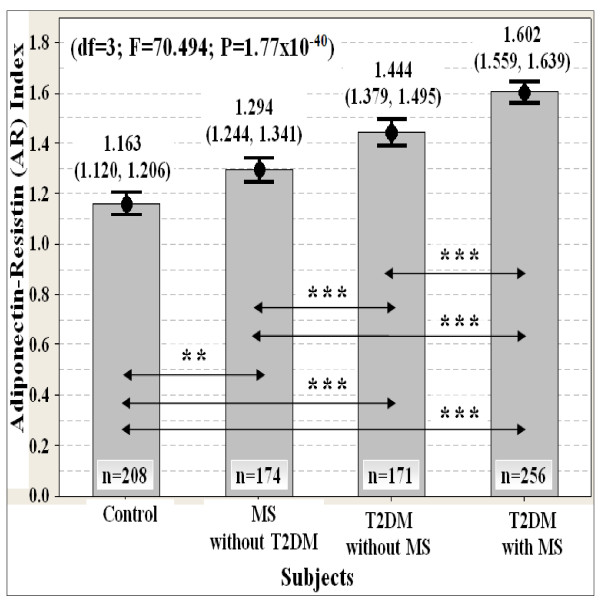
Association of the adiponectin-resistin (AR) index with T2DM and MS susceptibility (n = 809). Data are expressed as mean (95% confident interval). ANCOVA test was used, followed by pairwise comparison using 1,000 stratified bootstrap samples with bias corrected and accelerated (BCa) 95% CI for multiple testing bias corrections due to deviation of normality. The p-value was also adjusted for covariate ages with stratified ethnicity. The location of statistically significant differences are displayed as the double arrow. Significant levels: P* < 0.05, P** < 0.01, P*** < 0.001. Note: T2DM = type 2 diabetes; MS = metabolic syndrome.